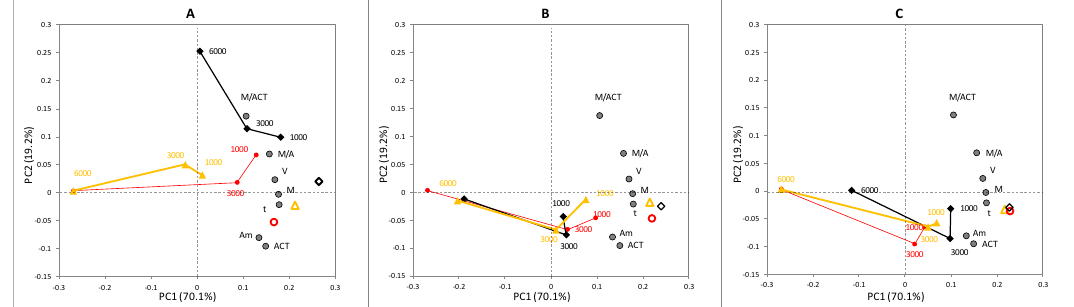
Figure 3. Biplot of the space of variance generated in the principal component analysis (PCA) study from the locomotion metrics data (Block A). ( A ): the score distribution of the treatments with the no ascorbic acid pre-exposure group; ( B ): the score distribution of the treatments with the 5 mM ascorbic acid pre-exposure group; ( C ): the score distribution of the treatments with the 5 – 10 mM ascorbic acid pre-exposure group. AA: yellow triangles; PA: black diamond; PP: red circles. Empty symbols represent the control cases (without nitrite) exposure group.